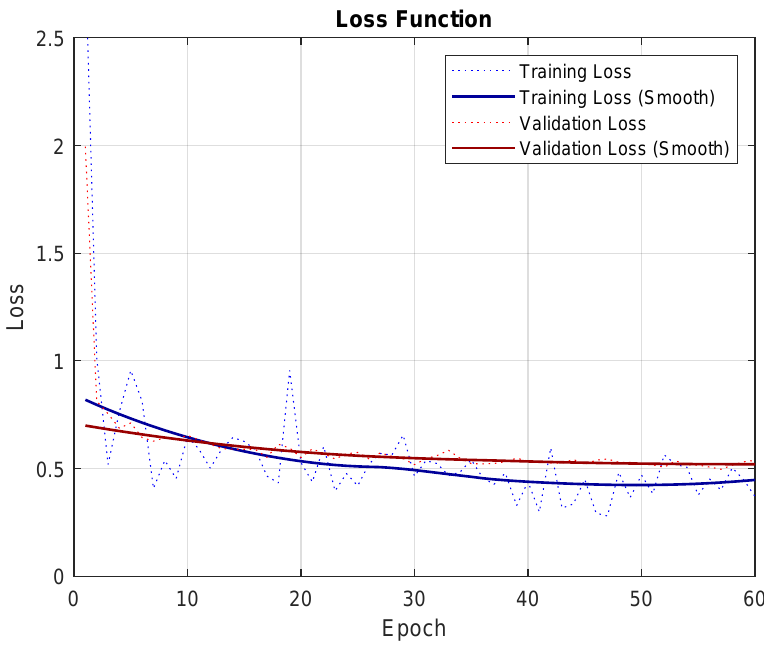
Figure 7. Loss function for the “Base” experiment with DeepLabV3+ for